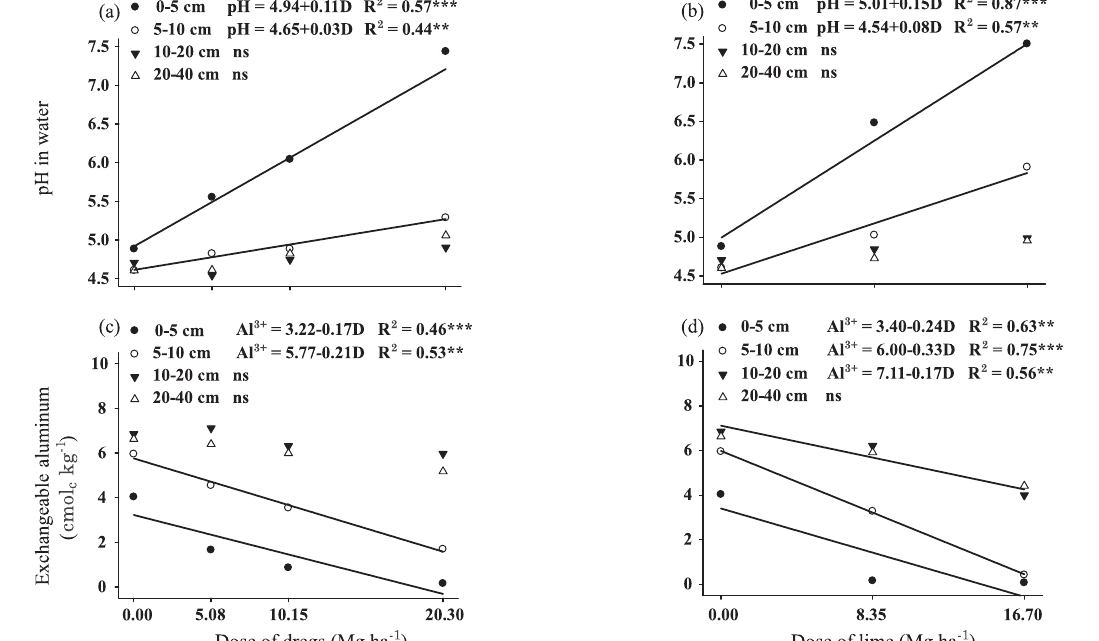
figure 1. ph in water and exchangeable aluminum (Al 3+ ) in the layers of a humic cambisol amended with doses (d) of dregs (a, c) and lime (b, d), applied to the soil surface in 2004/2006. Bocaina do sul, sc, 2010. (*, **, *** and ns: significant at 5, 1, 0.1 % and not significant,